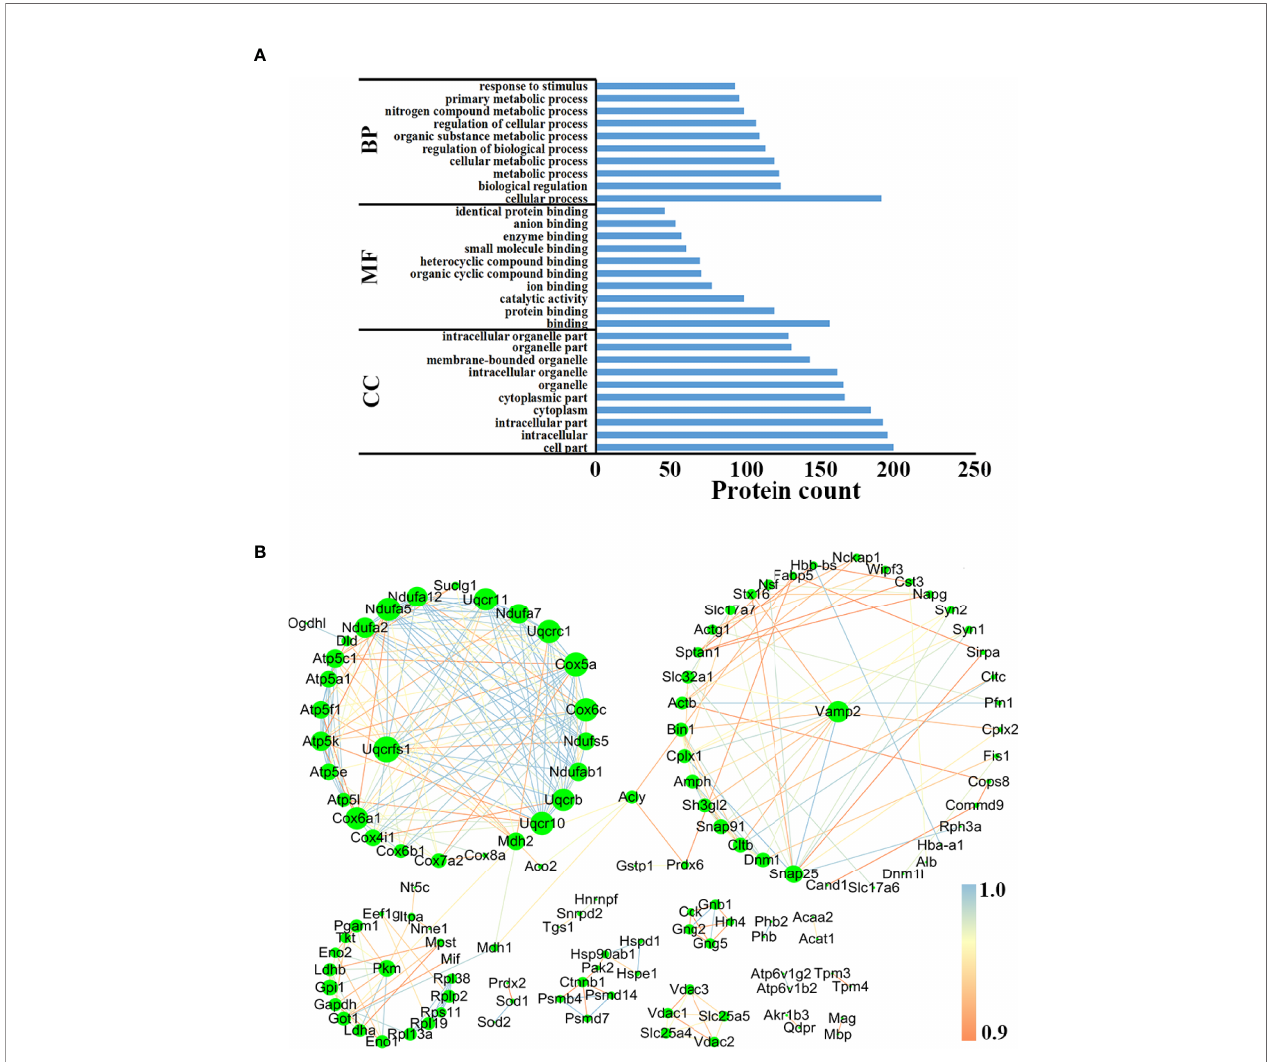
FIGURE 6 | Functional analysis of the precursor protein of DEPs in the comparison between the AI and the control group. (A) GO analysis. (B) PPI